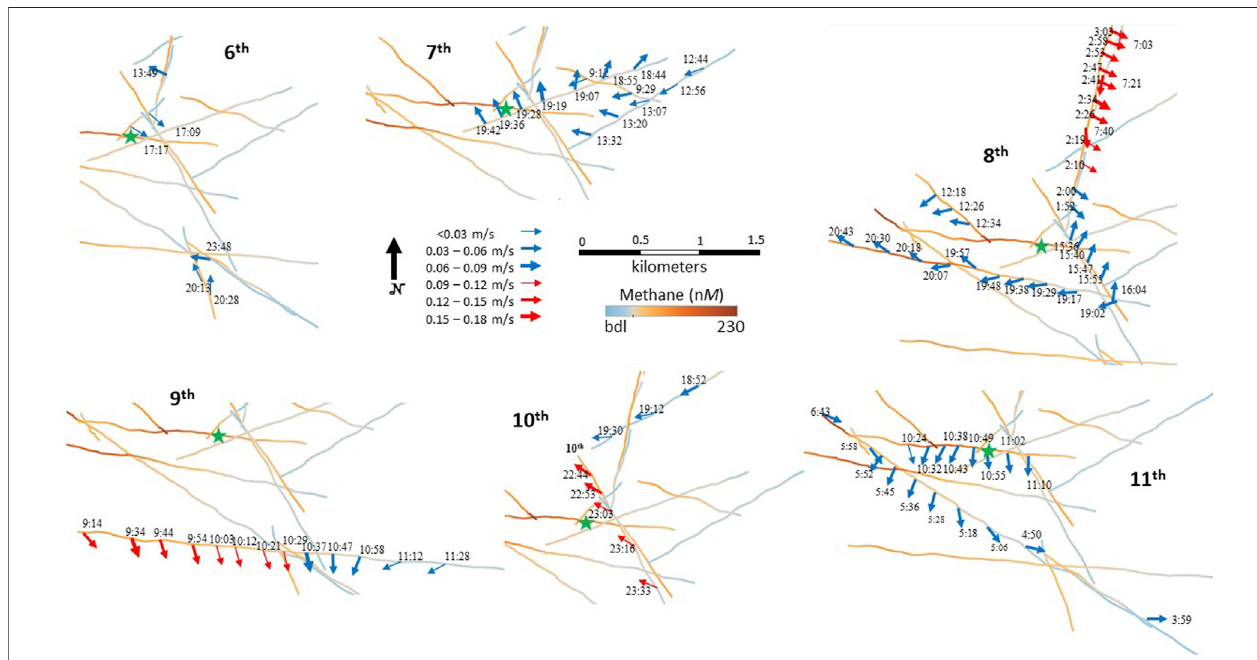
FIGURE12| Detailed dailyaveragenear-bottom currentmeasurements.Dataasper Figure10 butsplitout foreachday withacquisitiontimesindicatedat thetail of each vector.